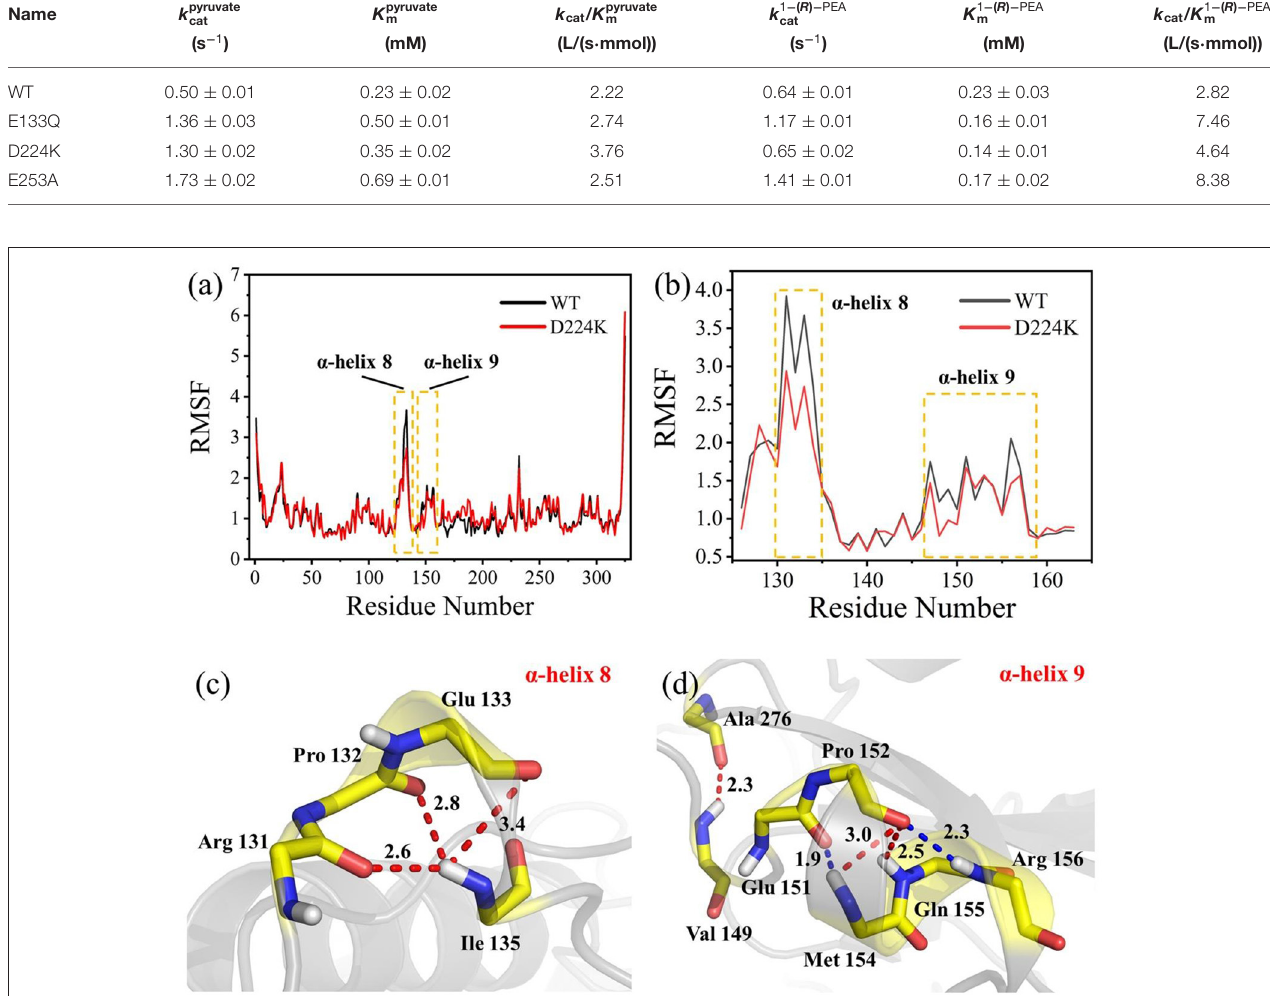
FIGURE 4 | MD analysis of At -ATA and D224K using YASARA at 313K in the last 20 ns. (a) The RMSF values of At -ATA and D224K; (b) the detail RMSF values of α -helix 8 and α -helix 9; (c,d) 3D view of two α -helix structures. The hydrogen bonds were displayed by dotted line with red and